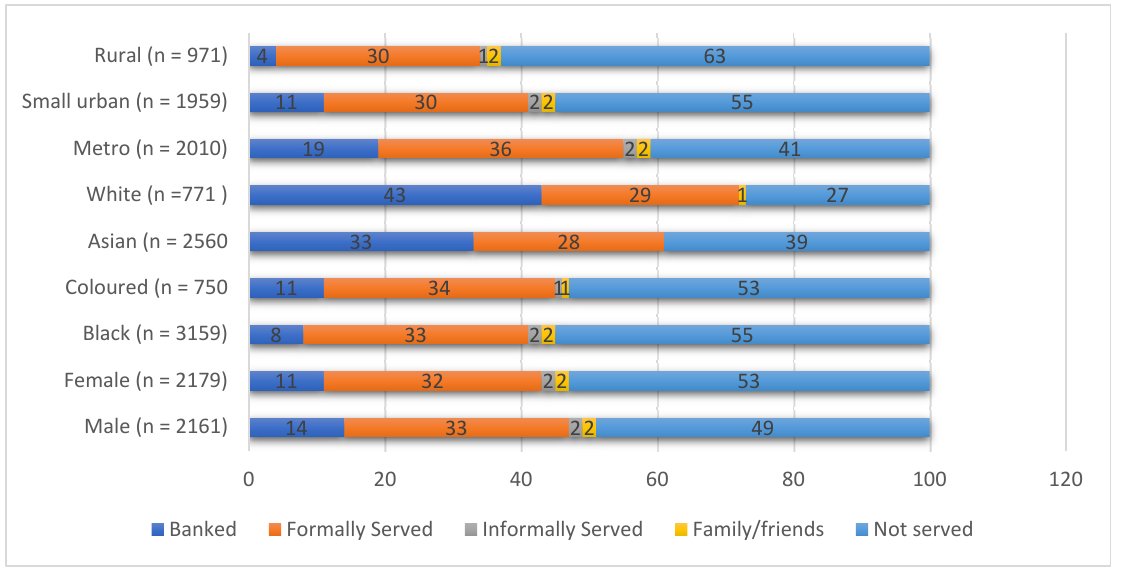
Table 2. Borrowing by demographics 2016.